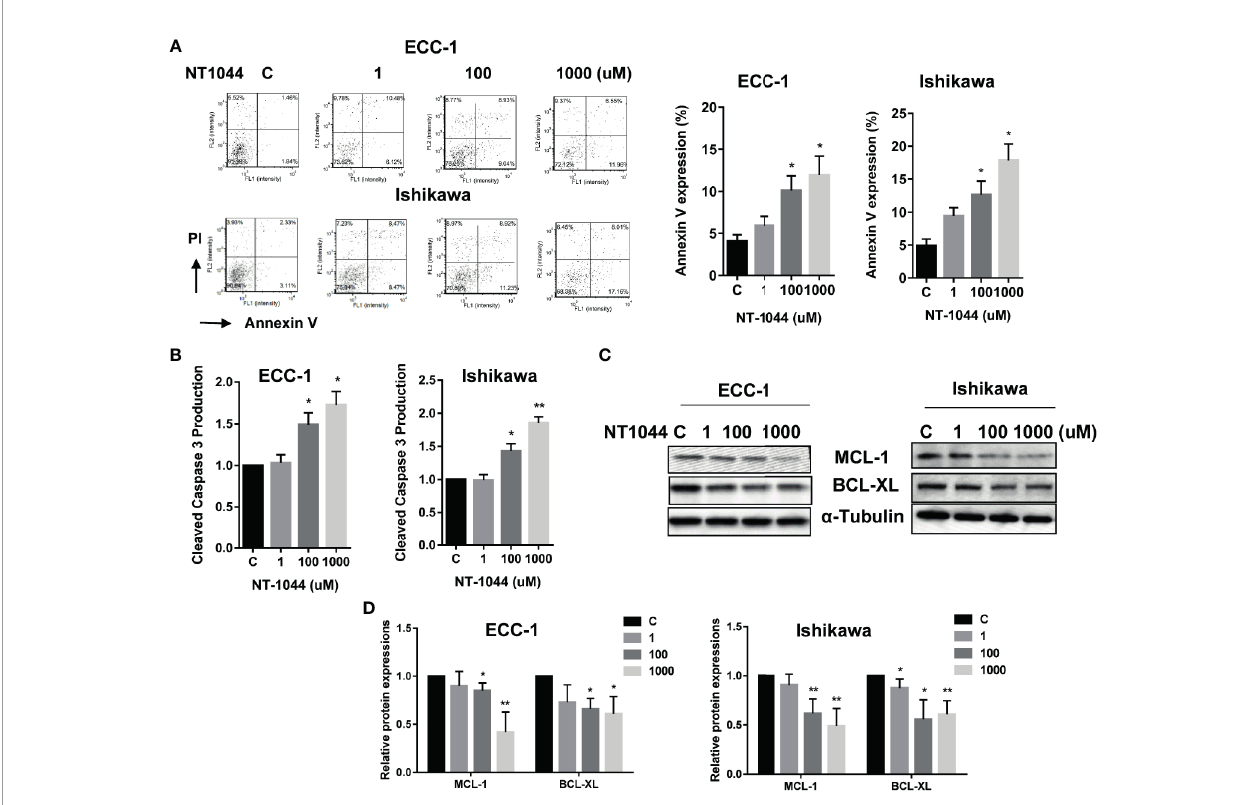
FIGURE 3 | NT-1044 induced apoptosis in EC cells. The ECC-1 and Ishikawa cells were cultured for 24 hours and then treated with NT-1044 for 12 hours. NT- 1044 increased Annexin V expression in a dose-dependent manner in both cells (A) . Both cell lines were treated with NT-1044 for 12 hours. Cleaved caspase 3 was measured by ELISA assay. The results showed that NT-1044 increased cleaved caspase 3 activity in both cell lines (B) . Western blotting showed that NT-1044 decreased the expression of BCL-XL and MCL-1 in a dose-dependent manner in both cell lines after 18 hours of exposure (C, D) . *p < 0.05, **p <